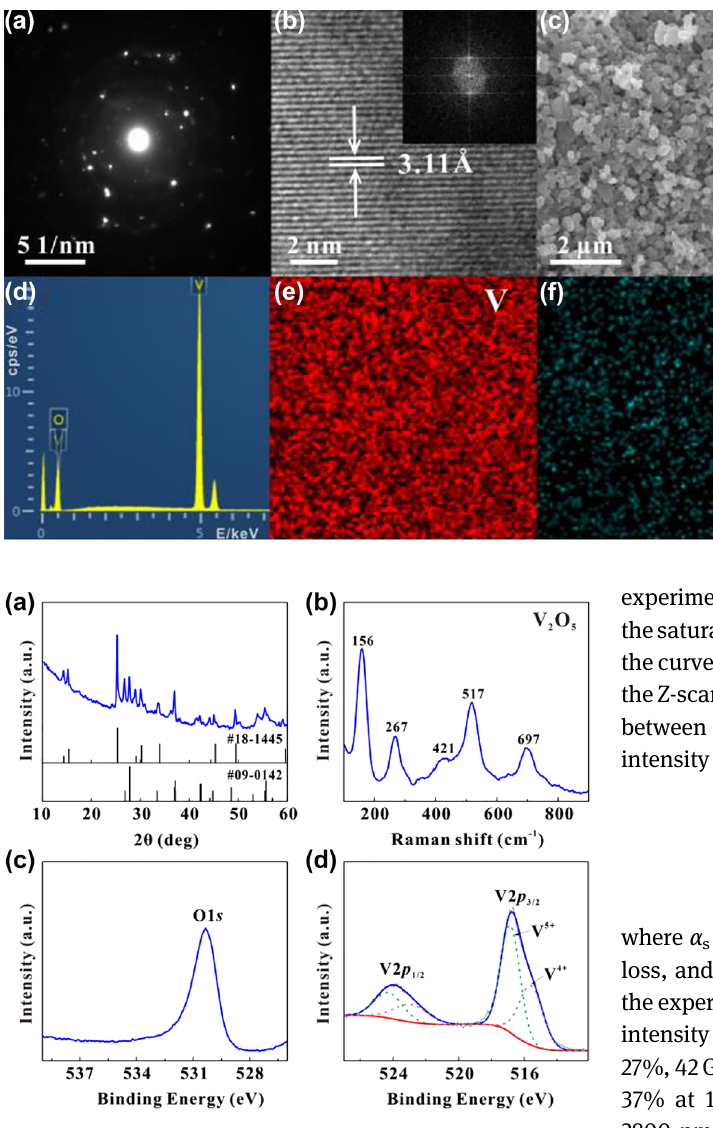
Figure 2: Characterization of samples. (a)XRD patterns.(b) Ramanspectrallines. (c) XPSspectrallinesof O element. (d) XPS peak separation spectral lines of V element.